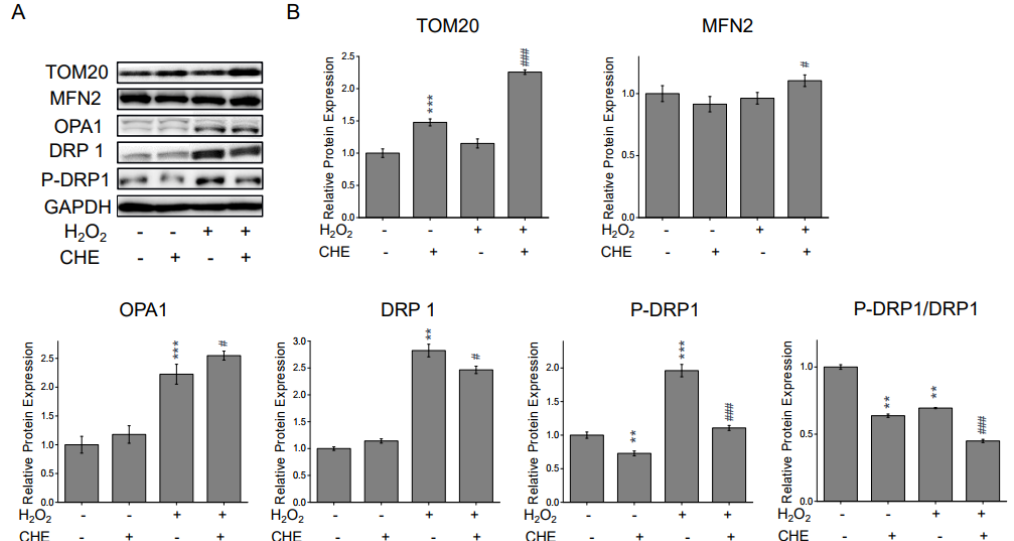
Figure 5. CHE increased TOM20, OPA1, and MFN2 protein expression and decreased DRP1 and P-DRP1 protein expression. The cells were pre-treated with 5 μ M CHE or 0.1% DMSO (vehicle control) for 2 h and then incubated with or without 500 μ M H 2 O 2 for an additional 24 h before being subjected to Western blot analysis. ( A ) Compared with ARPE-19 cells treated with H 2 O 2 -only and pre-treated with CHE and H 2 O 2 , CHE increased TOM20, MFN2, and OPA1 protein expression and decreased DRP1 and P-DRP1 protein expression. Protein levels of TOM20, MFN2, OPA1, DRP1, and P-DRP1 were quantified via Western blotting. ( B ) Representative Western blot results. ** p < 0.01, *** p < 0.001, versus control group; # p < 0.05, ### p < 0.001, versus the H 2 O 2 -treated group.